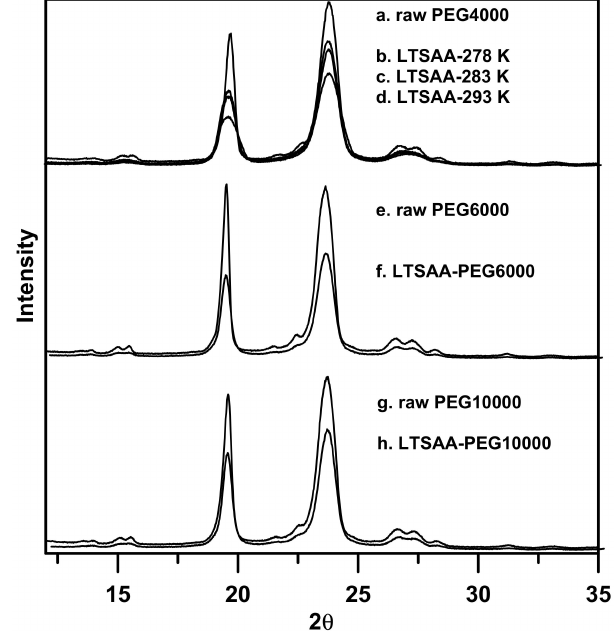
Figure 10. The XRD analyses of the PEG particles produced using